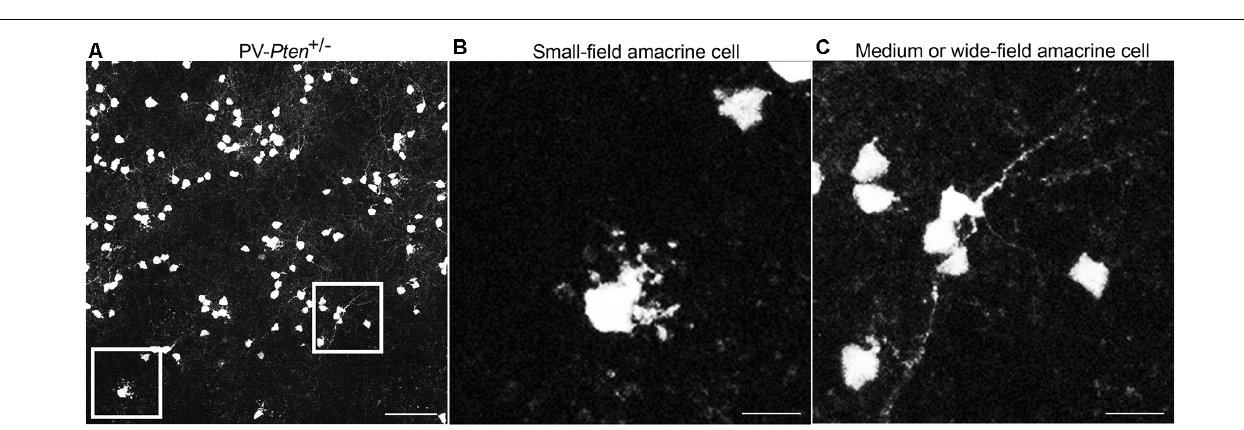
FIGURE 2 | Expression of tdTomato fluorescence in the inner nuclear layer (INL) of PV- Pten mice. (A) TdTomato fluorescence in the INL of a PV- Pten +/- mouse. (B) High magnification (box area from A ) of a small field amacrine cell. (C) High magnification (box area from A ) of a medium or wide-field amacrine cell. z -step = 0.5 µ m. Twenty optical sections were compressed for viewing. Scale bar: 50 µ